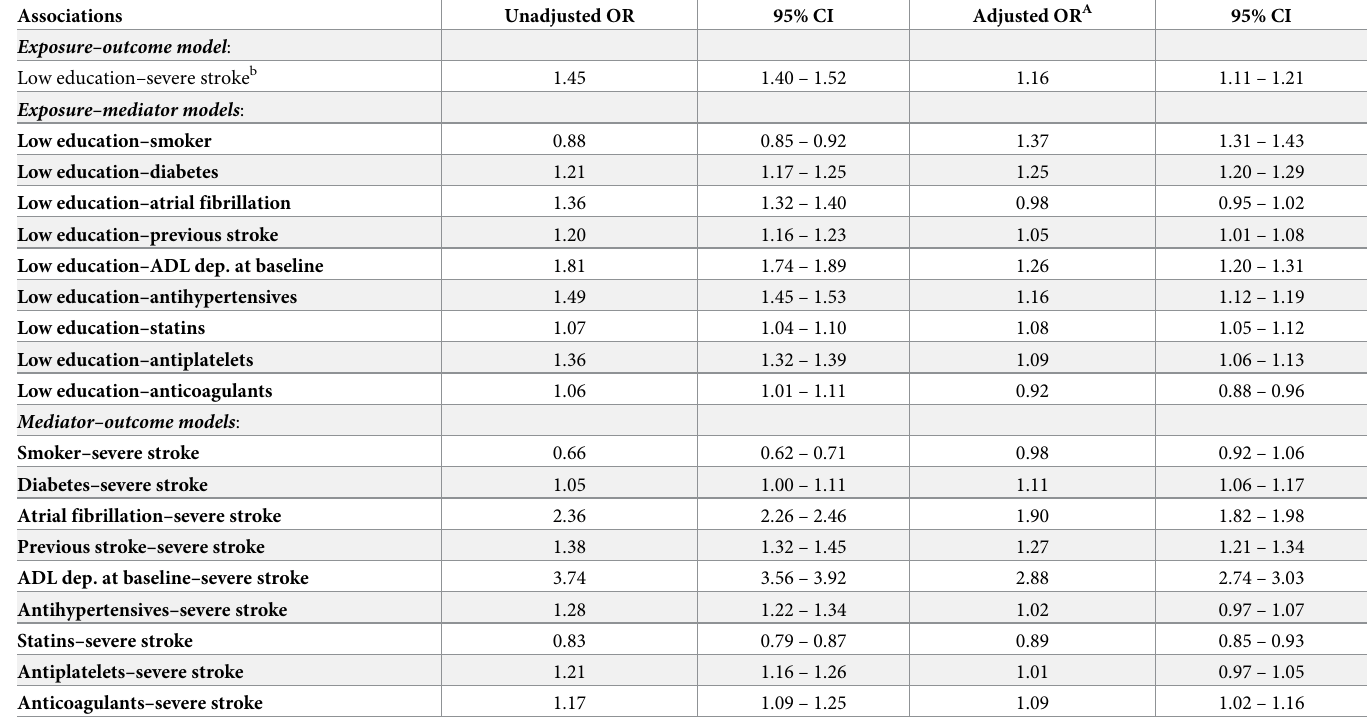
Table 2. Unadjusted and adjusted associations between the exposure, mediators and the outcome estimated through separate logistic regression models. Associations